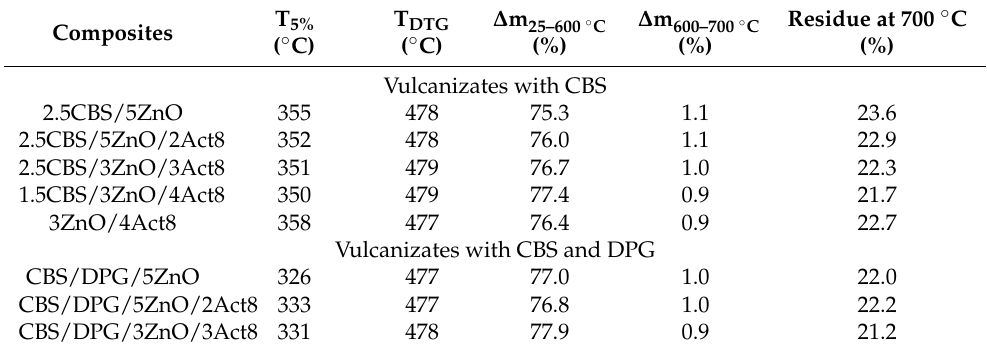
Table 7. Thermal stability of SBR vulcanizates measured by thermogravimetry (TG) (T 5% , onset temperature of thermal decomposition; T DTG , DTG peak temperature; ∆ m, total mass loss during